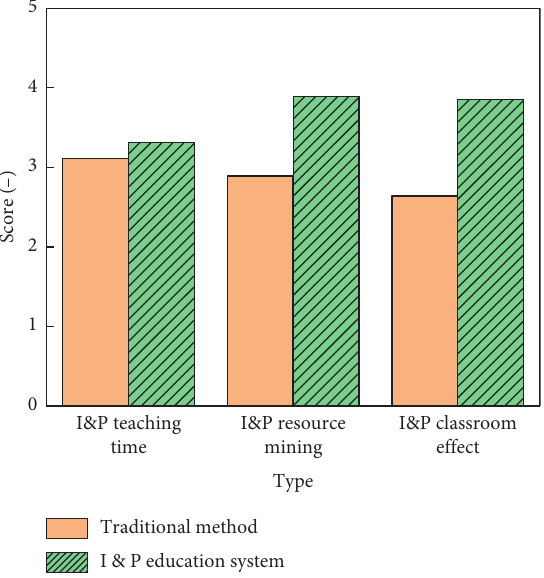
Figure 16: Application effect of I&P teaching